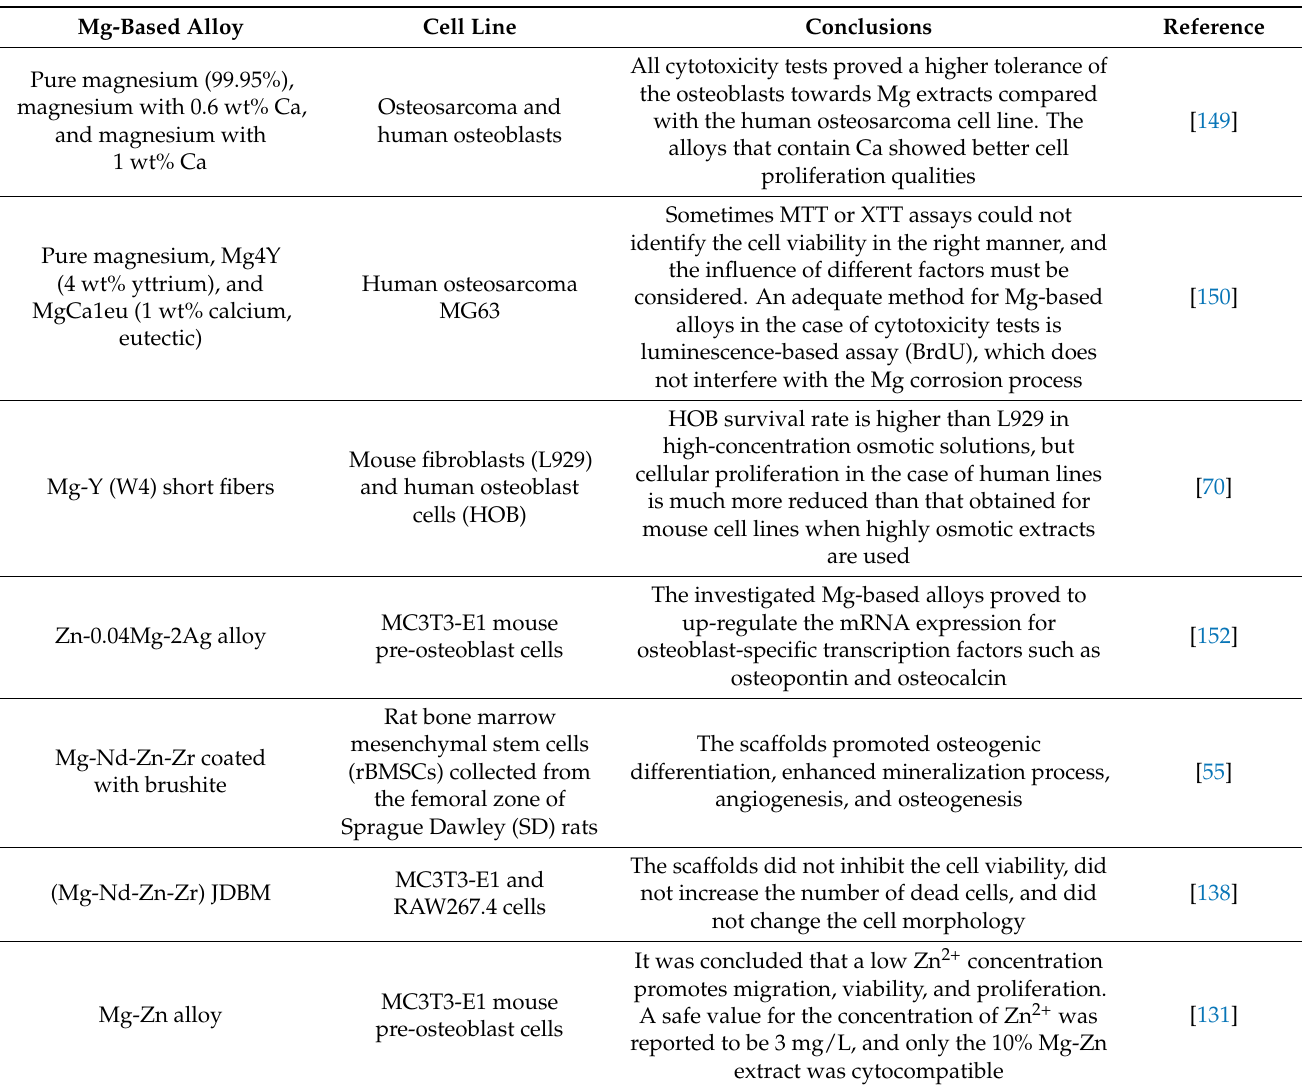
Table 7. Mg-based scaffolds’